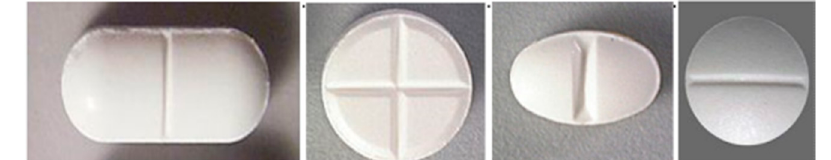
Figure 2. Different geometry scored tablets. Images are obtained from https://consumermedsafety.org. Figure 2. Di ff erent geometry scored tablets. Images are obtained from https: // consumermedsafety.org. Permission obtained by Jennifer Gold at ISMP. Permission obtained by Jennifer Gold at